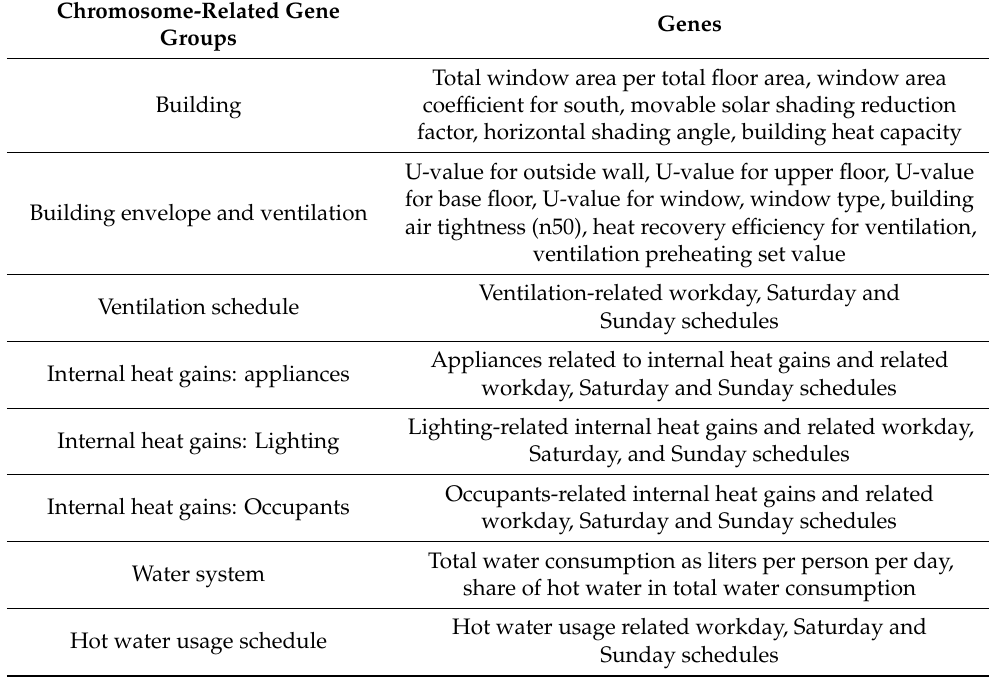
Table 1. Building model